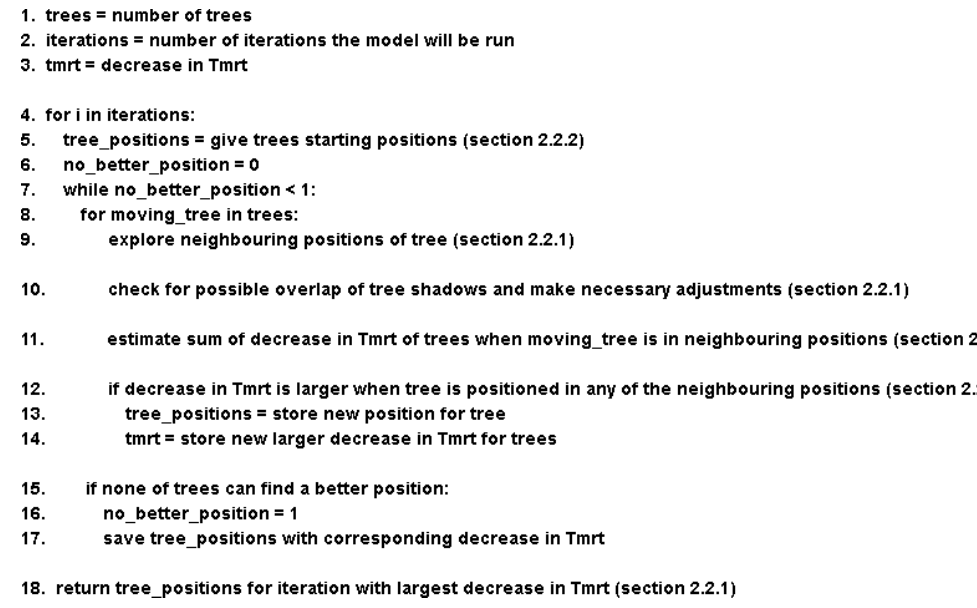
Figure 2. Pseudocode of the tree locator algorithm in the